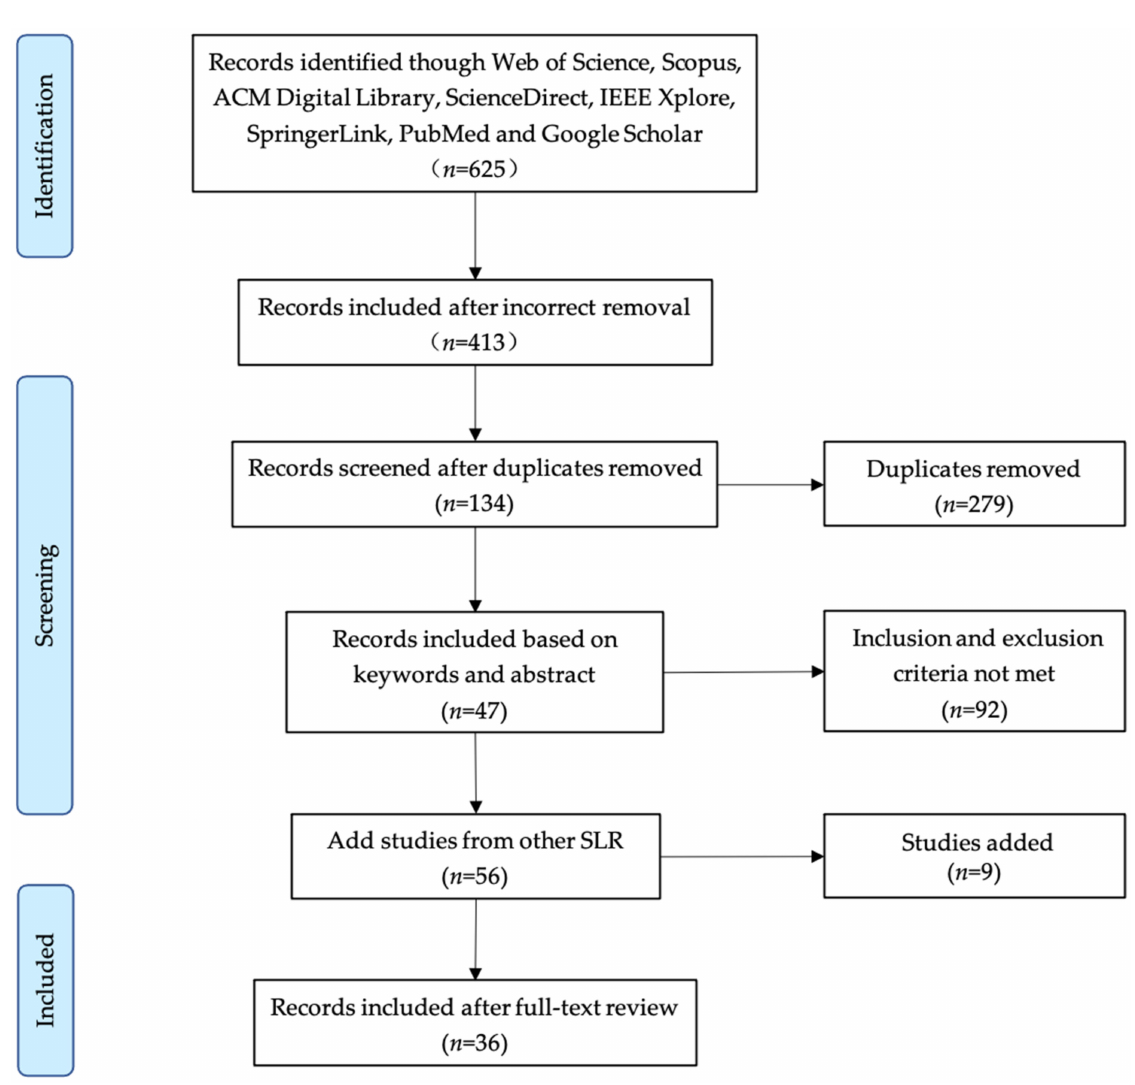
Figure 1. Literature search and selection